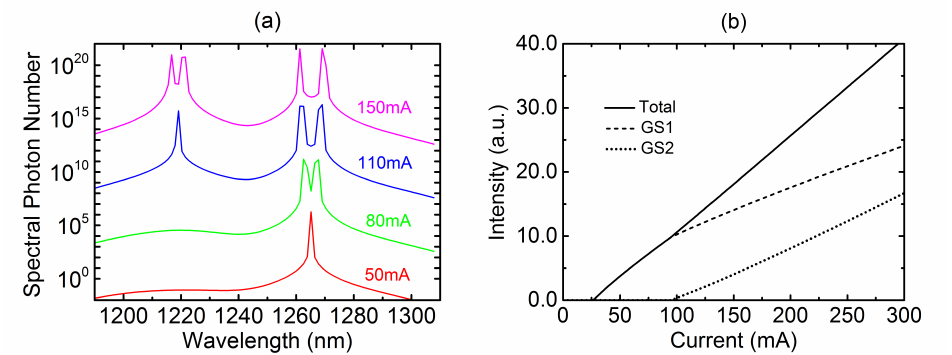
Figure 2. Simulation of digitally chirped multilayer quantum-dot (DC-MQD) lasers: ( a ) L-I characteristics and ( b ) lasing spectra.